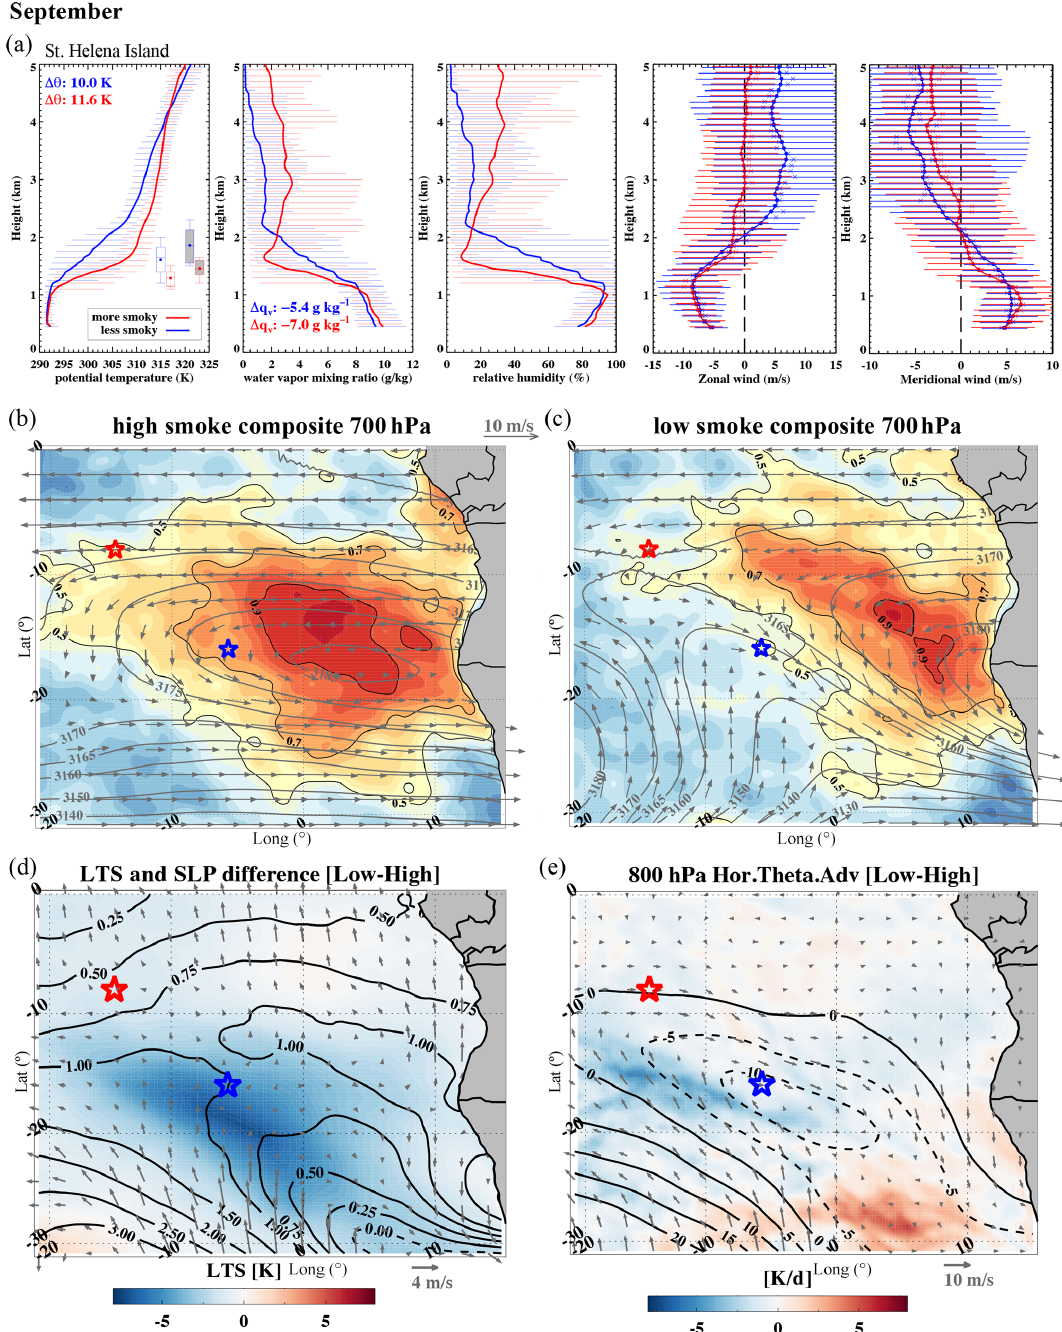
Figure 8. (a) Similar to Fig. 7b but for St. Helena from 2d prior to those with high and low smoke loadings at Ascension. Zonal and meridional components of the winds are shown instead of wind speed. (b, c) Corresponding composite mean MODIS daily liquid cloud fraction (colored contours), 700hPa ERA5 geopotential heights (meters; gray contours), and winds (gray vectors). (d) Difference (low– high) in composite mean lower tropospheric stability (LTS; defined as θ 800hPa − θ 1000hPa ; colored contours), sea level pressure (SLP; hectopascals; black contours), and 10m winds (gray vectors). (e) Low–high smoke composite difference in 800hPa horizontal temperature advection (colored contours), geopotential heights (meters; black contours) and winds (gray vectors). Locations of Ascension and St. Helena are indicated in red and blue stars, respectively, in panels (b–e)